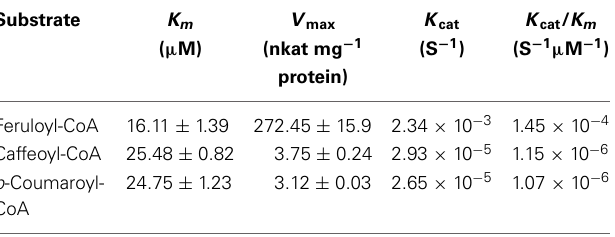
Table 1 | Kinetic properties of the recombinant GST-FaCCR protein.